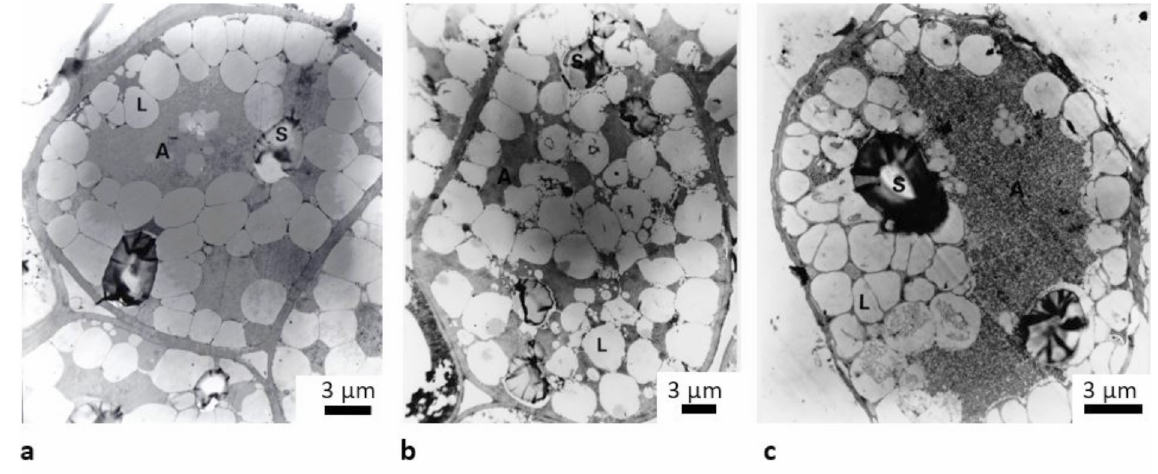
Fig. 5: Storage cells of T. cacao (a), T. grandiflorum (b) and T. bicolor (c) A: aleuron, S: starch grain, L: lipid vacuole Ultra-thin sections